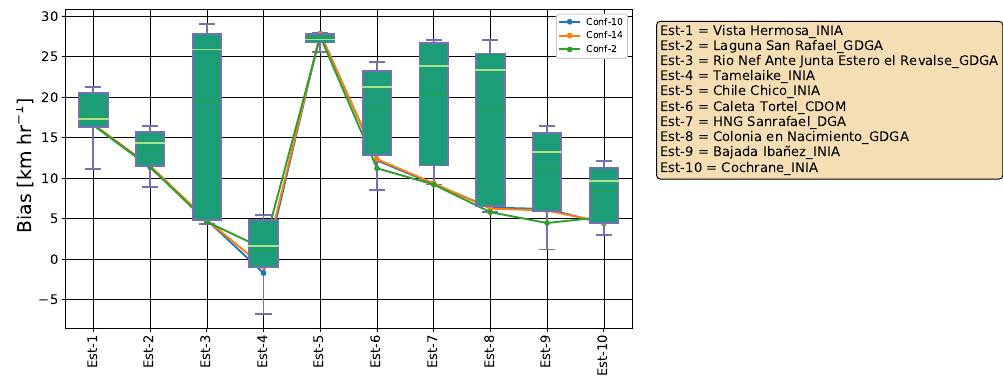
Figure 7. Wind speed model bias for all of the configurations.